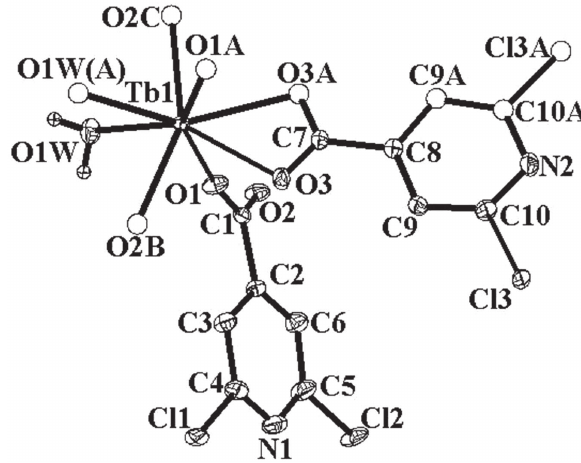
Table 1: Data collection and handling.